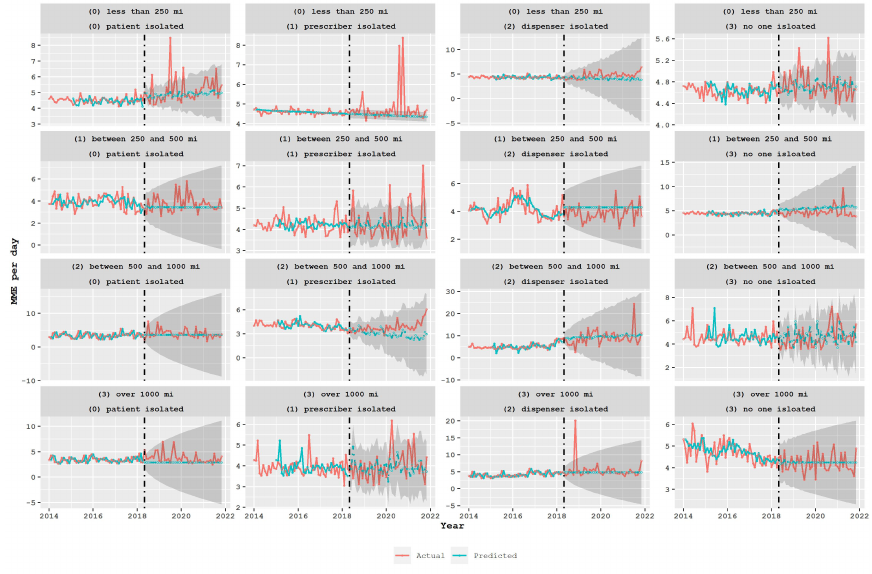
Figure 7. Average daily MME for benzodiazepine (control group) prescriptions in the state of South Carolina over a period of time (measured in months) for different proposed classes. The broken vertical line indicates the legislative intervention that was enacted in May 2018. The blue line represents the fit of the mathematical